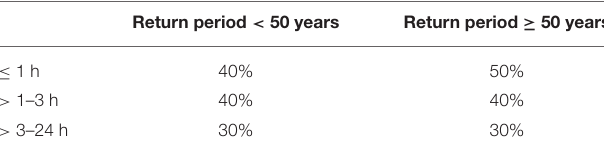
TABLE 3 | Recommended climate change allowance for heavy rainfall (modified from Dyrrdal and Førland,